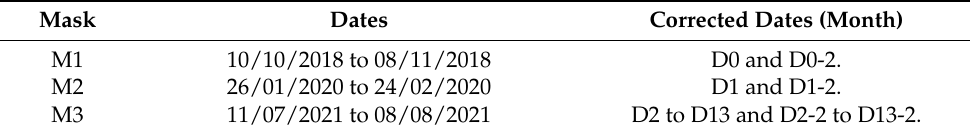
Figure 3. Workflow for construction of Bare Adjusted NTL Index (BANTLI). Table 2. The date ranges of the masks and the corrected dates.